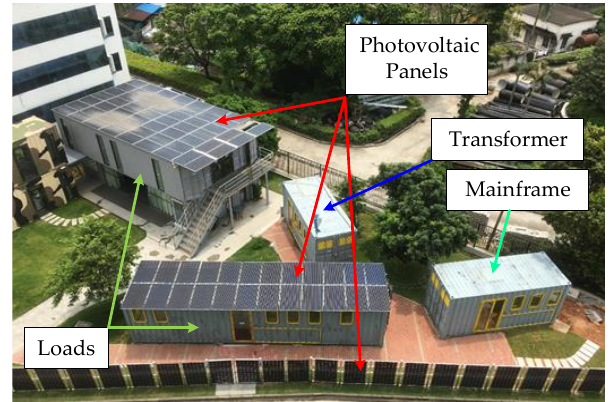
Figure 18. Gree Photovoltaic Cabin.